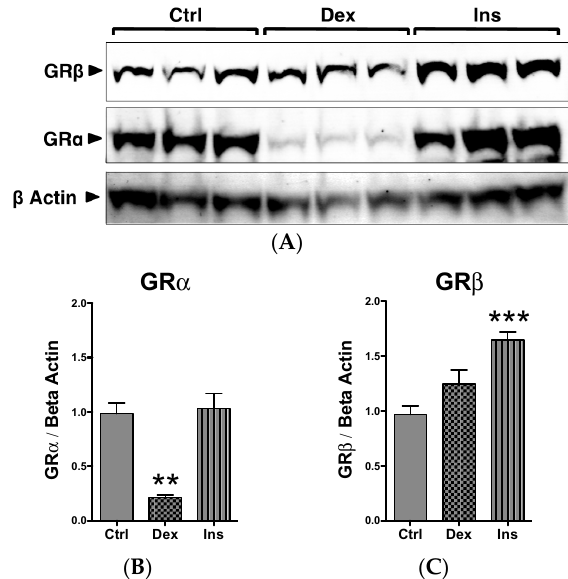
Figure 1. GR expression and responsiveness in C 2 C 12 myoblasts. ( A ) Western blot of C 2 C 12 myoblasts treated with vehicle (Ctrl), dexamethasone (Dex), or insulin (Ins) for 24 h; ( B ) Quantification of GR α protein expression in response to Dex and Ins; ** p < 0.01 compared to Ctrl; ( C ) Quantification of GR β protein expression in response to Dex and Ins; *** p < 0.001 compared to Ctrl. n = 3 experiments. Data expressed as mean ± SEM.